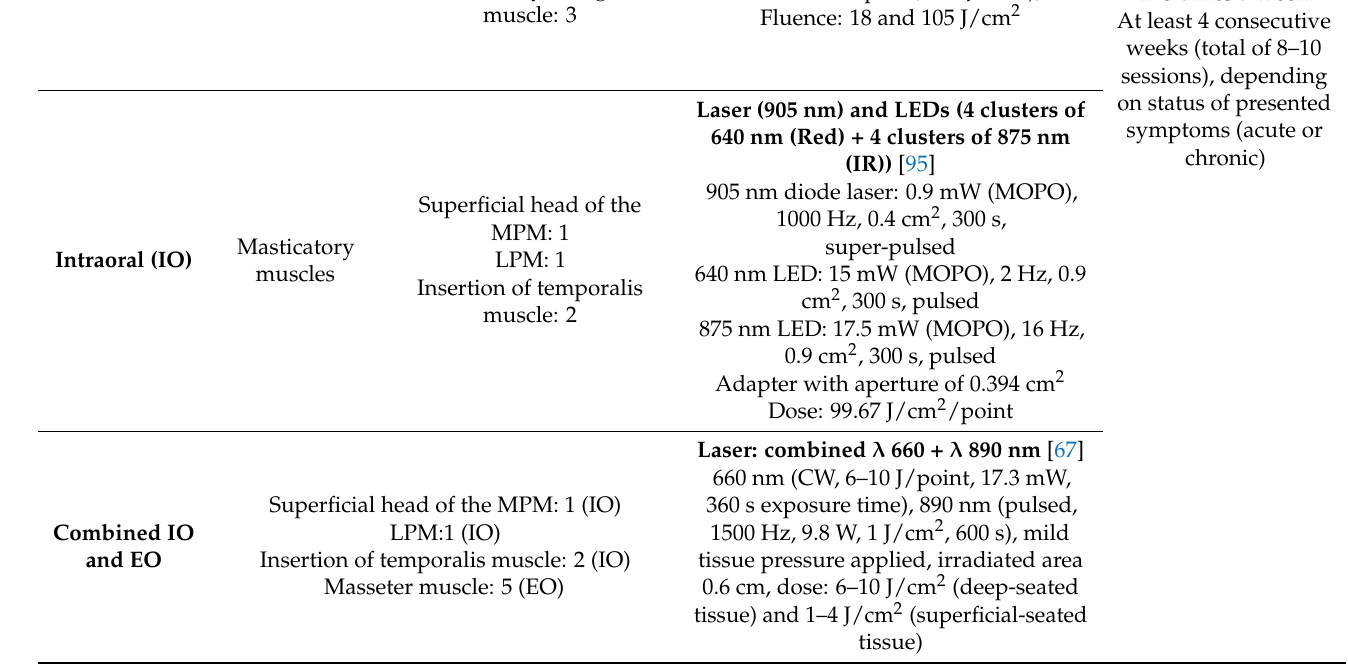
PBM Device Characteristics, Application and Treatment Protocol **